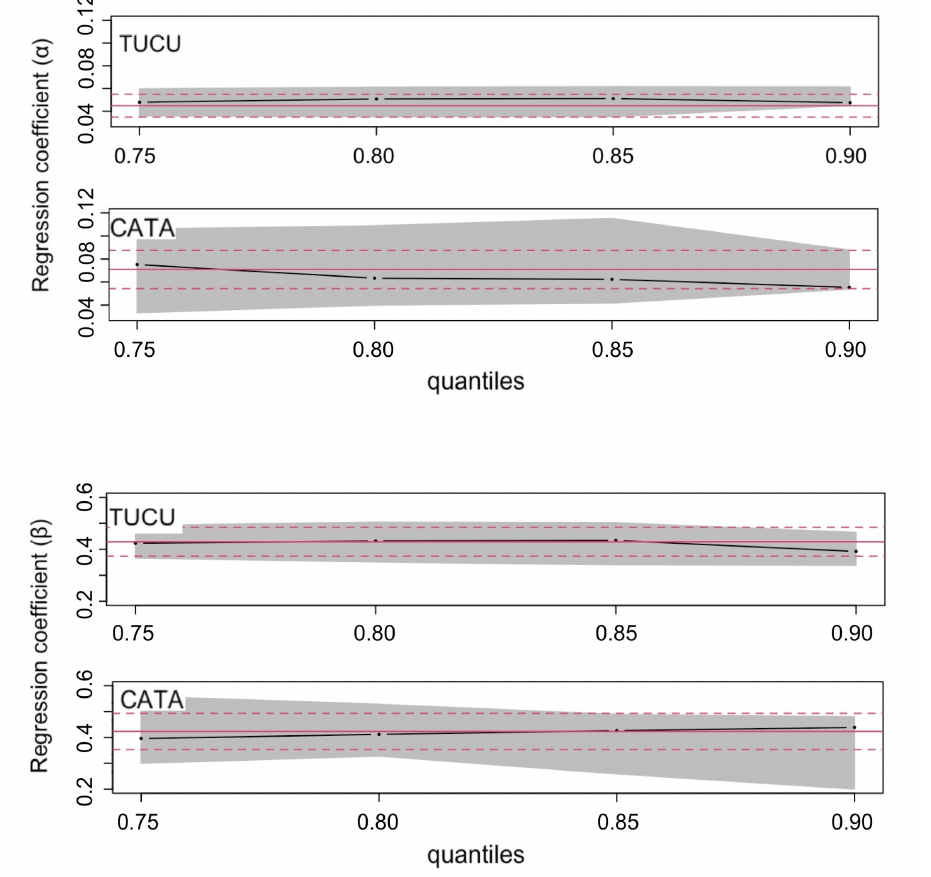
Figure 9. The coefficients of quantile regression analysis with their 90% confidence bounds (gray shading), Equations (7)–(9) for 0.75, 0.8, 0.85, 0.9 quantiles and for TUCU and CATA stations. The least- squares regression coefficients (red solid line) with their 90% confidence bounds (dashed lines) are represented.